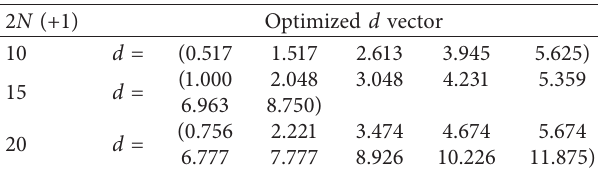
� 0.2, normalized to 0.4 λ . 0